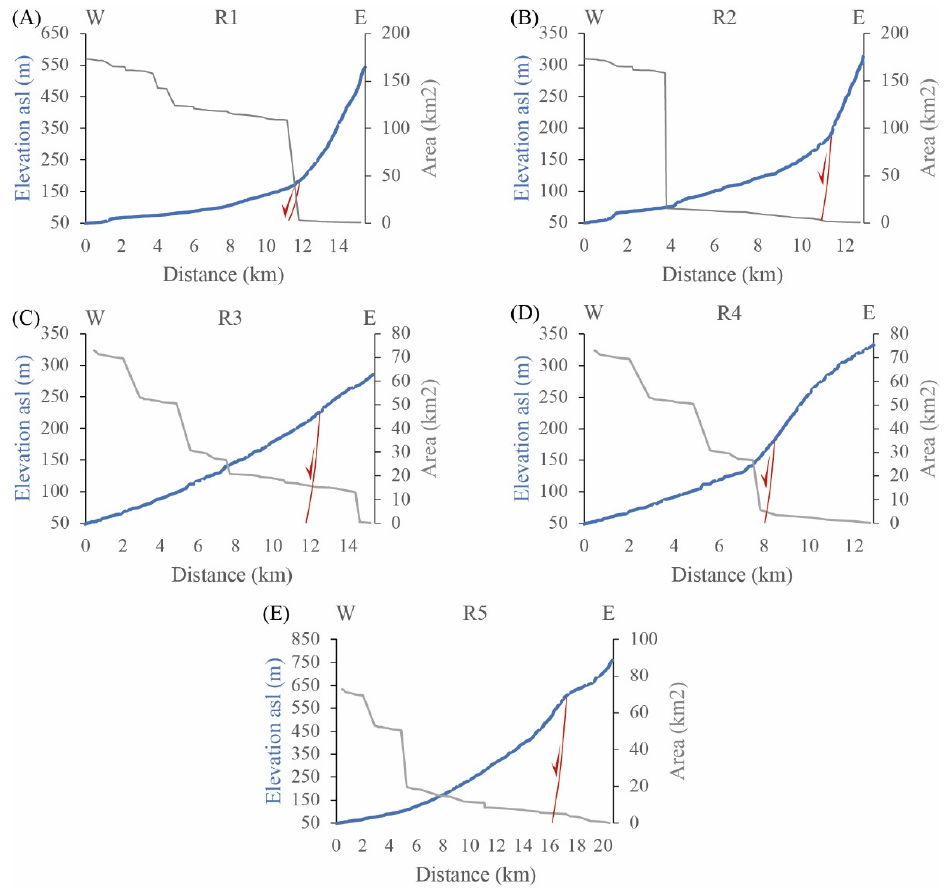
Figure 5. ( A – E ) Longitudinal profiles (blue lines) of the R1–R5 reaches of the Amato River, respectively (see Figure 3B for the traces), against catchment areas (grey lines).